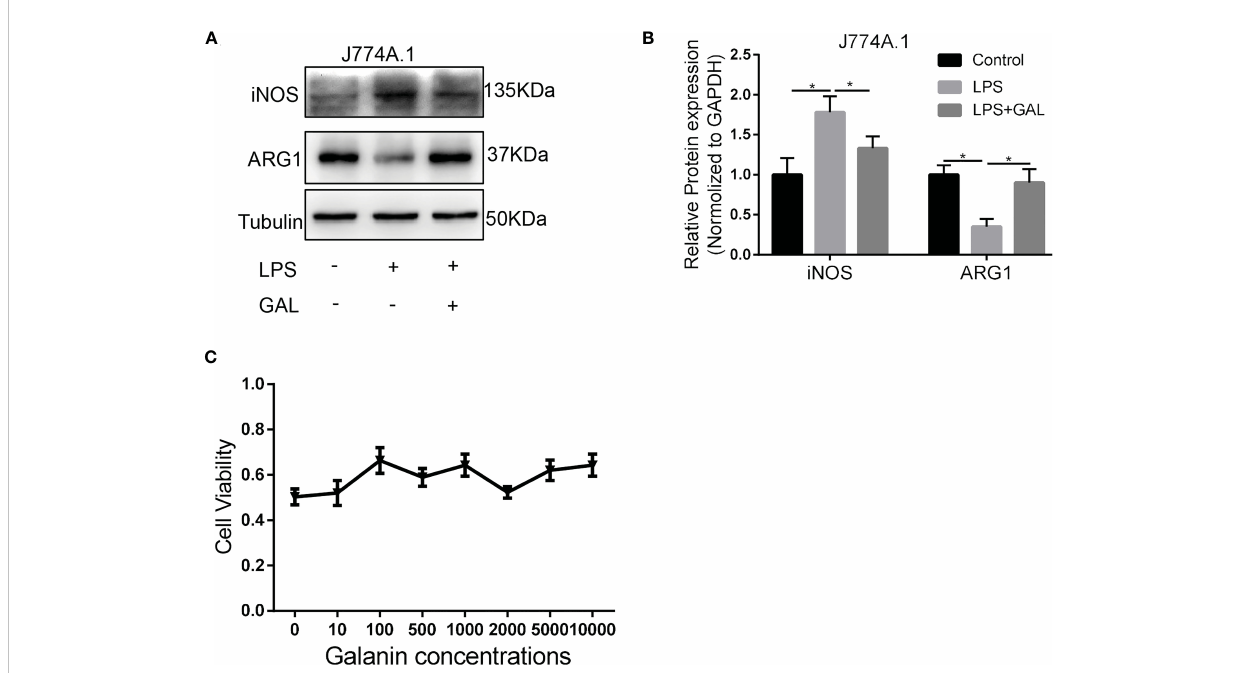
FIGURE 5 Galanin induces M2-polarization phenotype in murine macrophages. Murine macrophages were incubated with LPS to induce in fl ammation, or without (Control) and treated with or without galanin(1000nmol/L). (A) Representative image of western blot analysis of iNOS and ARG1 expression in J774A.1 macrophages. (B) Quanti fi cation of (A) *, p < 0.05. (C) CCK-8 assay of each concentration of galanin on J774A.1 macrophage proliferation. LPS, Lipopolysaccharide; iNOS, Inducible Nitric Oxide Synthase; ARG1, Arginase 1; GAL,